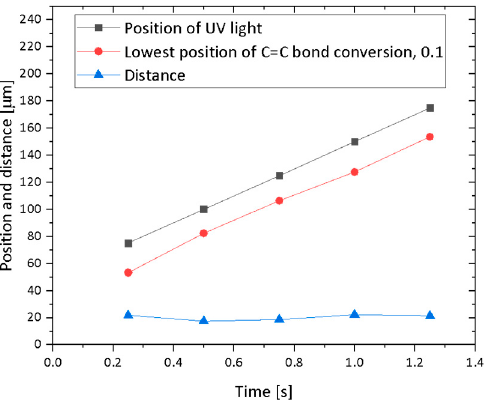
Figure 5. Position of UV light, the lowest position of C = C bond conversion (0.1), and their distance.